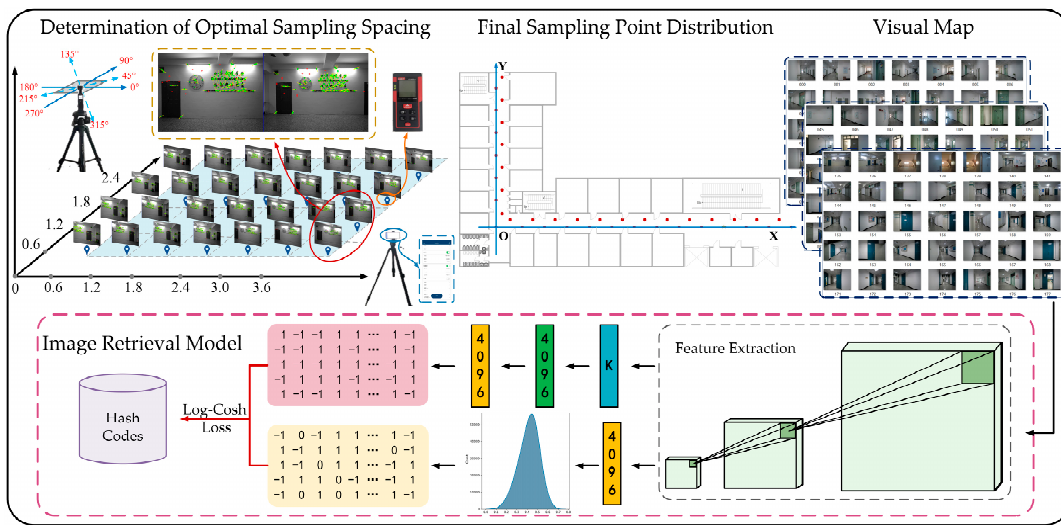
Figure 1. Roadmap of the research.